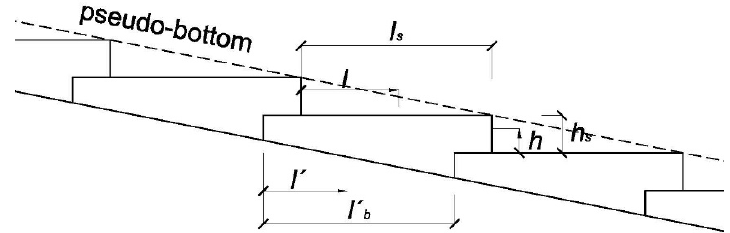
Figure 4. The measuring methacrylate WSB ( a ) and a block section with the locations of pressure sensors indicated ( b ) [28].